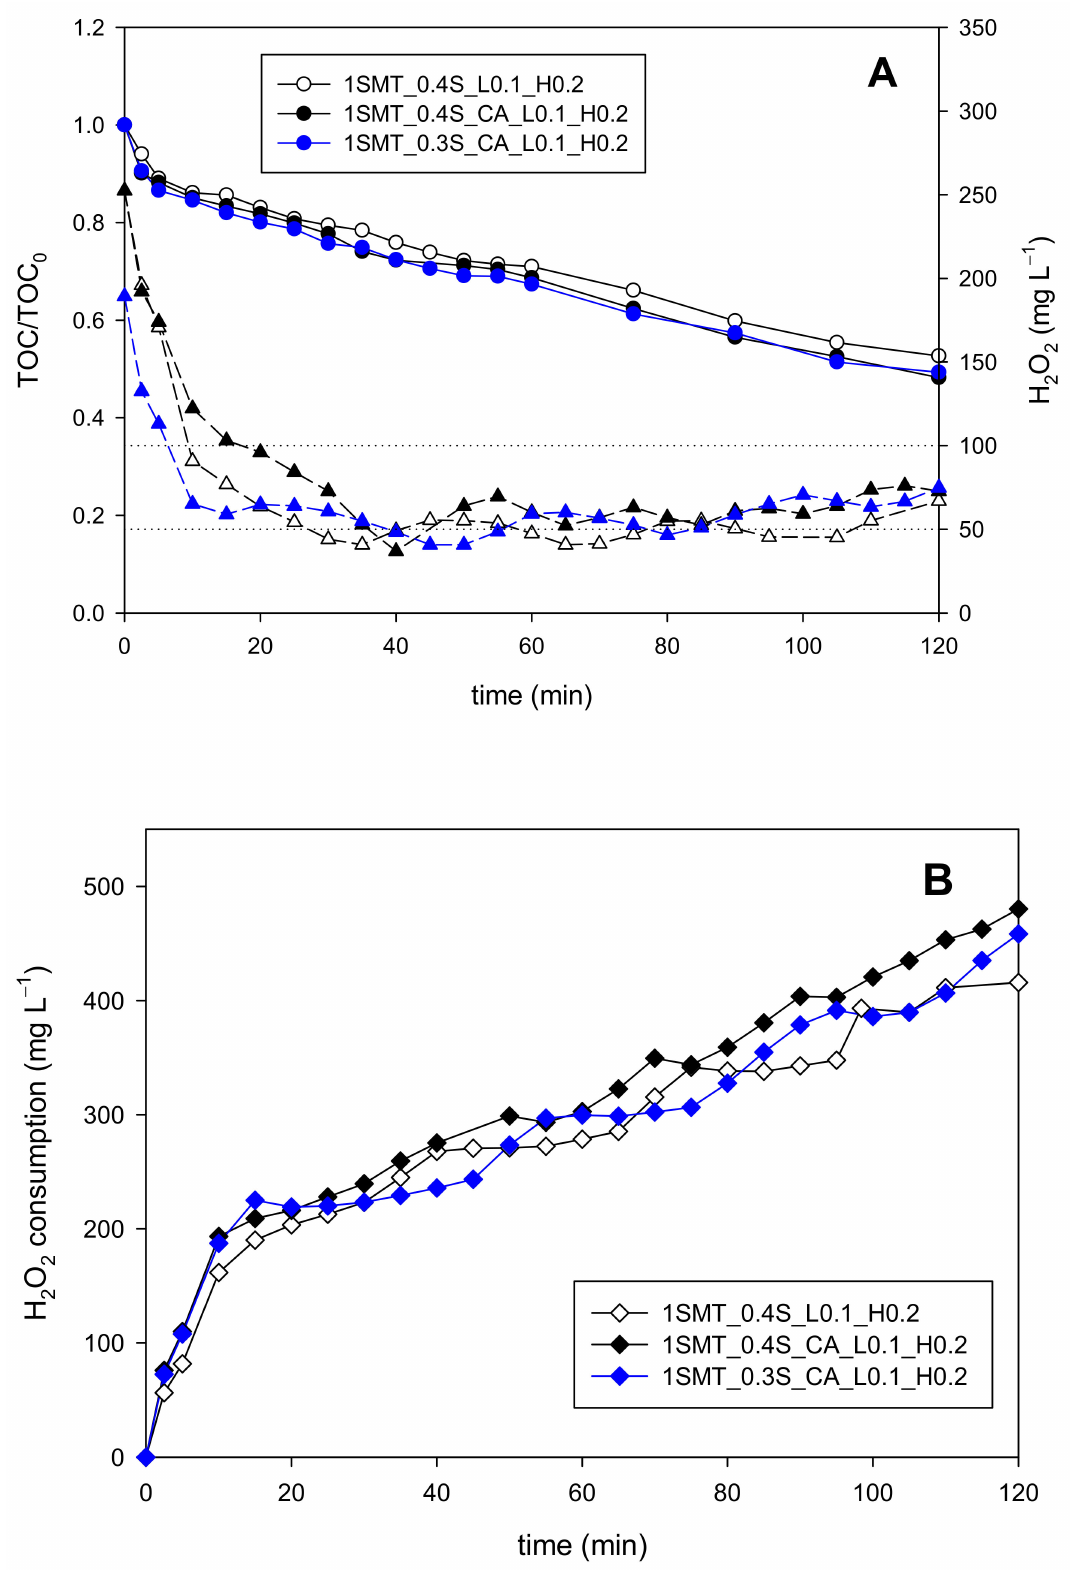
Figure 8. Mineralization (round symbols) and H 2 O 2 (triangular symbols) evolution ( A ) and H 2 O 2 consumption profiles ( B ) obtained with the 1SMT_0.4S_L0.1_H0.2, 1SMT_0.3S_CA_L0.1_H0.2 and 1SMT_0.4S_CA_L0.1_H0.2